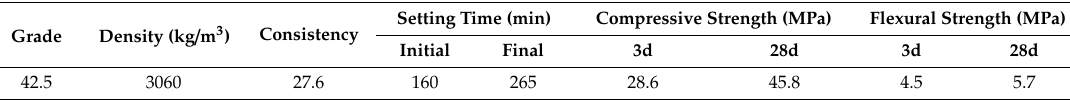
Table 2. Physical and mechanical properties of cement.